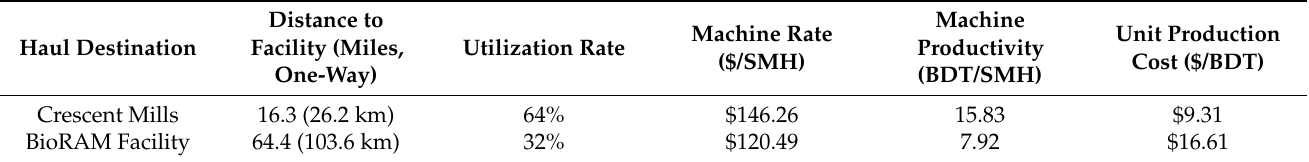
Table 6. Average distance, utilization rate, machine rate, productivity, and unit production costs for chipper based on haul destination.